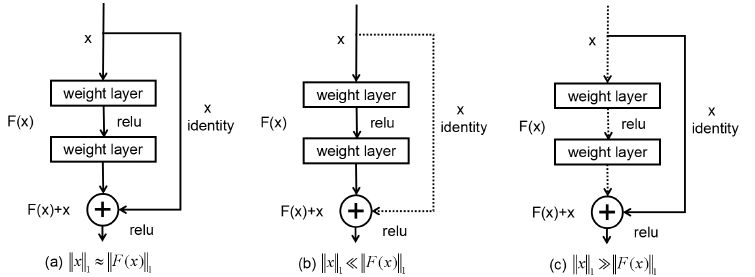
Figure 1. Schematic diagram of residual learning degradation. Dashed lines indicate non-existent paths. ( a ) represents (cid:107) x (cid:107) 1 ≈ (cid:107) F ( x ) (cid:107) 1 ; ( b ) represents (cid:107) x (cid:107) 1 (cid:28) (cid:107) F ( x ) (cid:107) 1 ; ( c ) represents (cid:107) x (cid:107) 1 (cid:29) (cid:107) F ( x ) (cid:107) 1